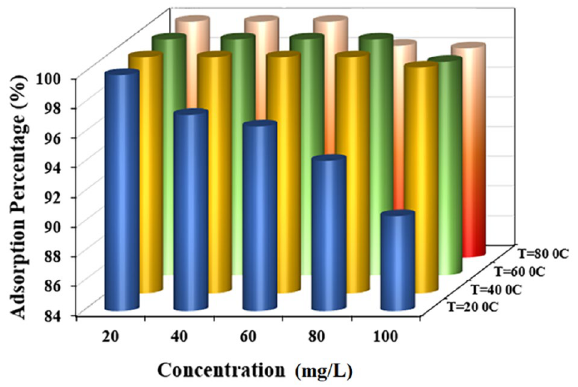
Figure 7. Percentage of cobalt absorption at 25 °C.